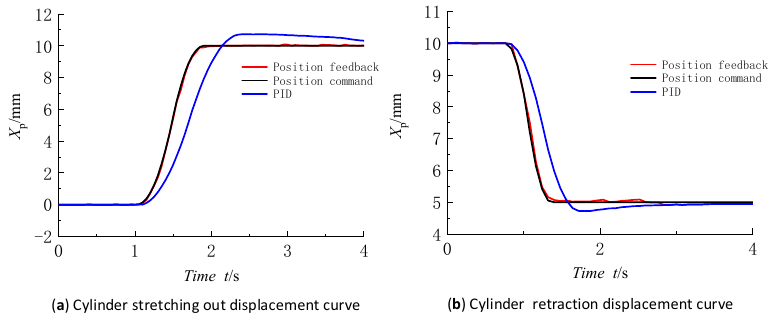
Figure 10. Control strategy performance comparison.